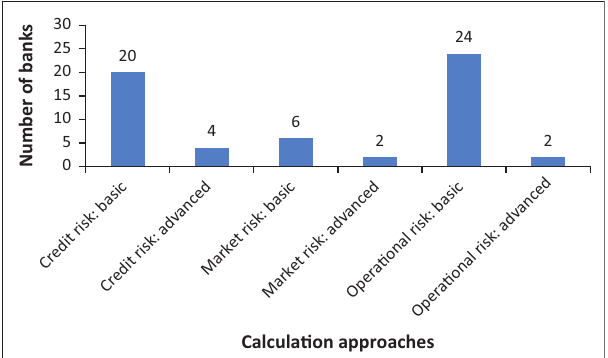
FIG URE 4: Approaches used to calculate credit, market and operational risk.